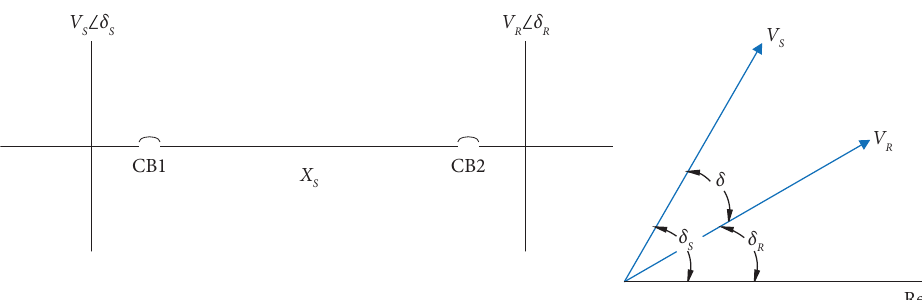
Figure 1: Sending and receiving ends of the transmission line.